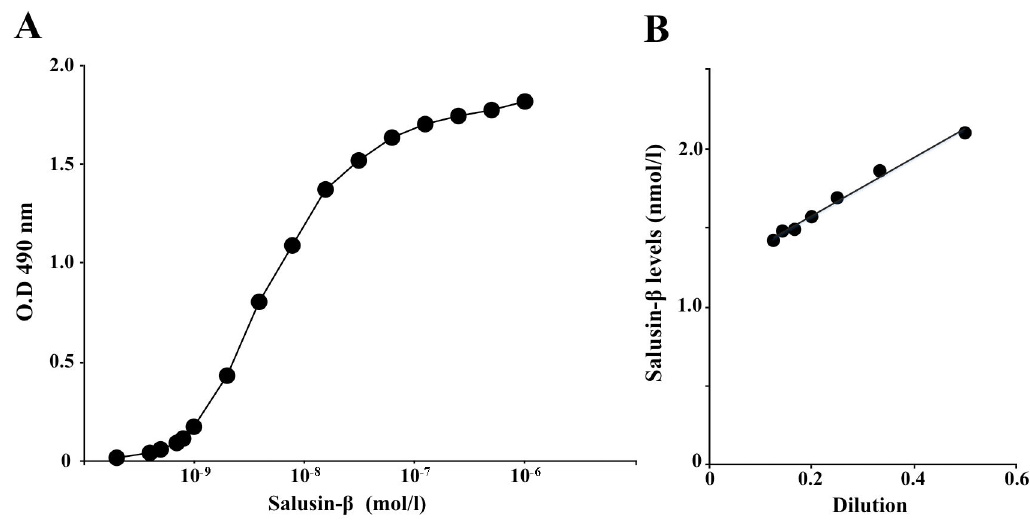
Figure 1. Validation of a competitive ELISA for quantifying plasma salusin-β levels in humans. A . Representative absorbance curve at 490 nm obtained from triplicate wells containing a range of standard human salusin-β peptides between 0.2 nmol/l and 1.0 µmol/l. B . Parallelism was determined by serial dilutions of pooled extracted human plasma in ELISA assay buffer to obtain 50%, 33.3%, 25%, 20%, 16.7%, 14.3%, and 12.5% plasma. Each sample was assayed in triplicate for determining salusin-β levels and linear regression was applied. Data points represent mean values